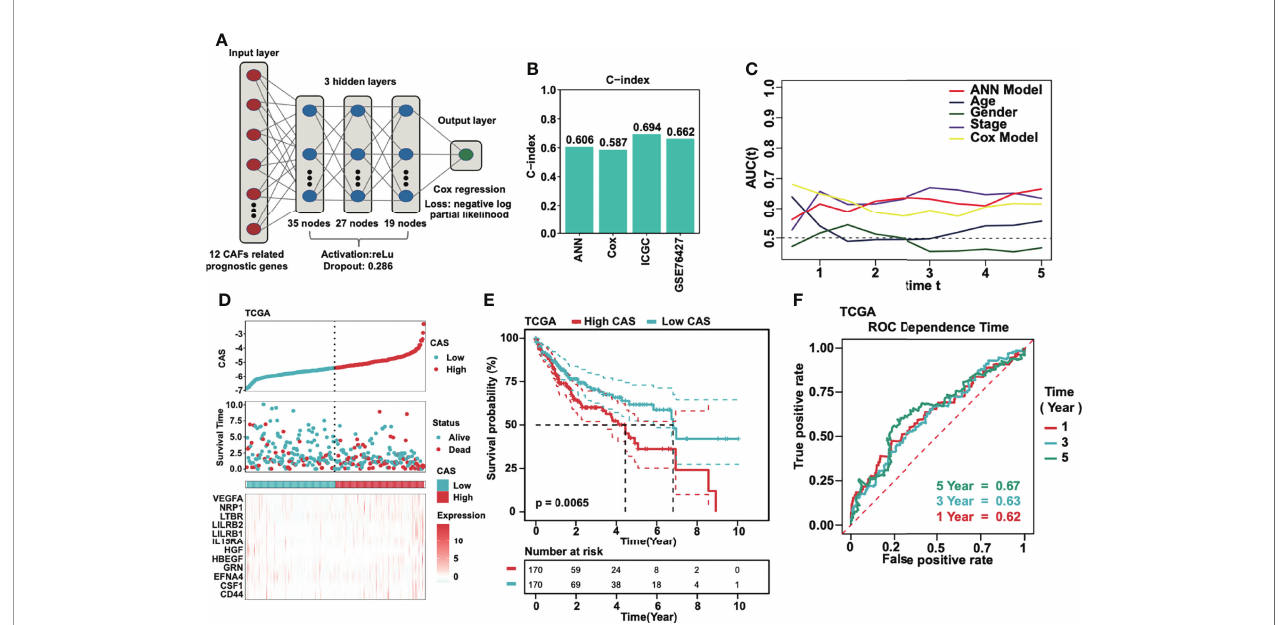
FIGURE 3 | Construction of the ANN model. (A) The schematic diagram of the constructed ANN model. (B) Detection of the C-index of the ANN, traditional Cox model, ICGC, and GSE76427. (C) AUC analyses of the constructed ANN model compared to the traditional Cox model and other parameters. (D) The CAS and corresponding survival status in each sample in the TCGA dataset. (E) Kaplan – Meier analysis of high- and low-CAS samples in the TCGA dataset. (F) ROC analysis of the ANN model in 1-, 3-, and 5-year survival prediction in the TCGA